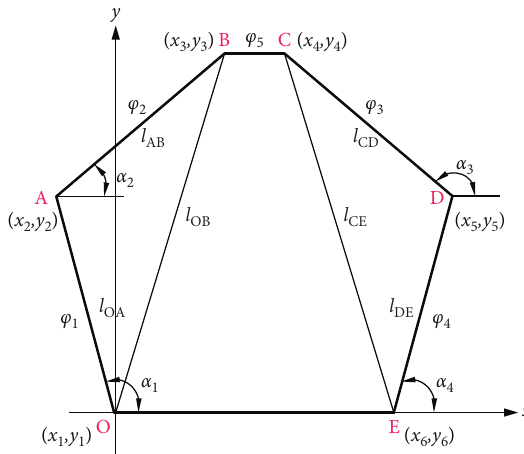
Figure 8: Coordinate system used in the derivation. Points O, A, B, C, D, and E are the rotation centers of each joint, not the middle points of the joints.